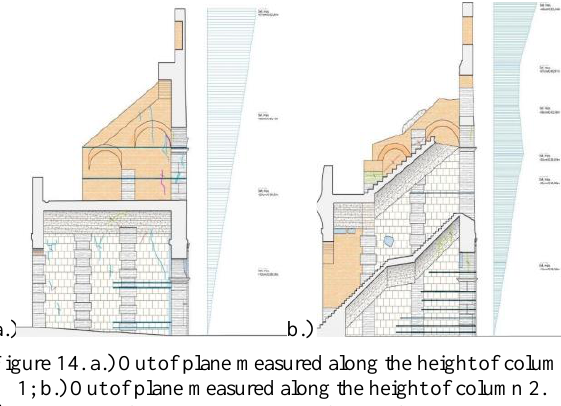
Figure 14. a.) Out of plane measured along the height of column 1; b.) Out of plane measured along the height of column 2.